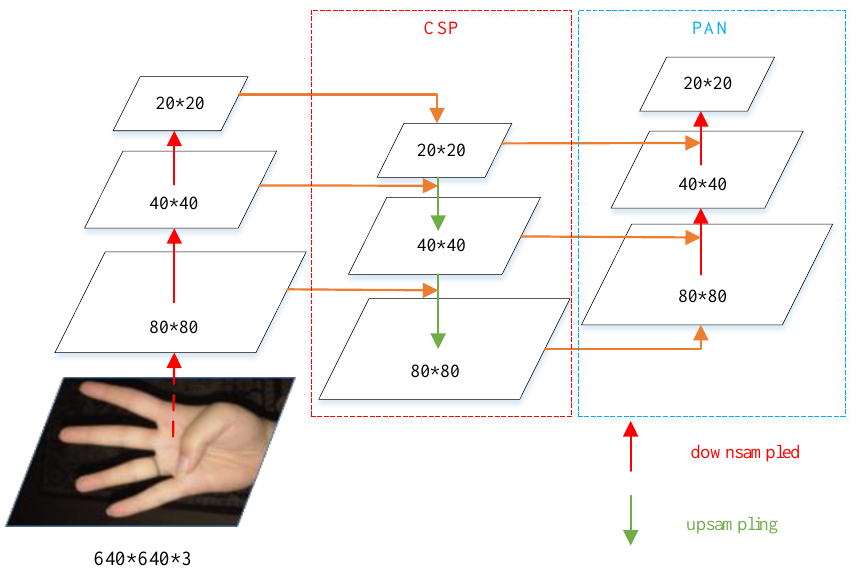
Figure 2. Structure of CSP and PAN.